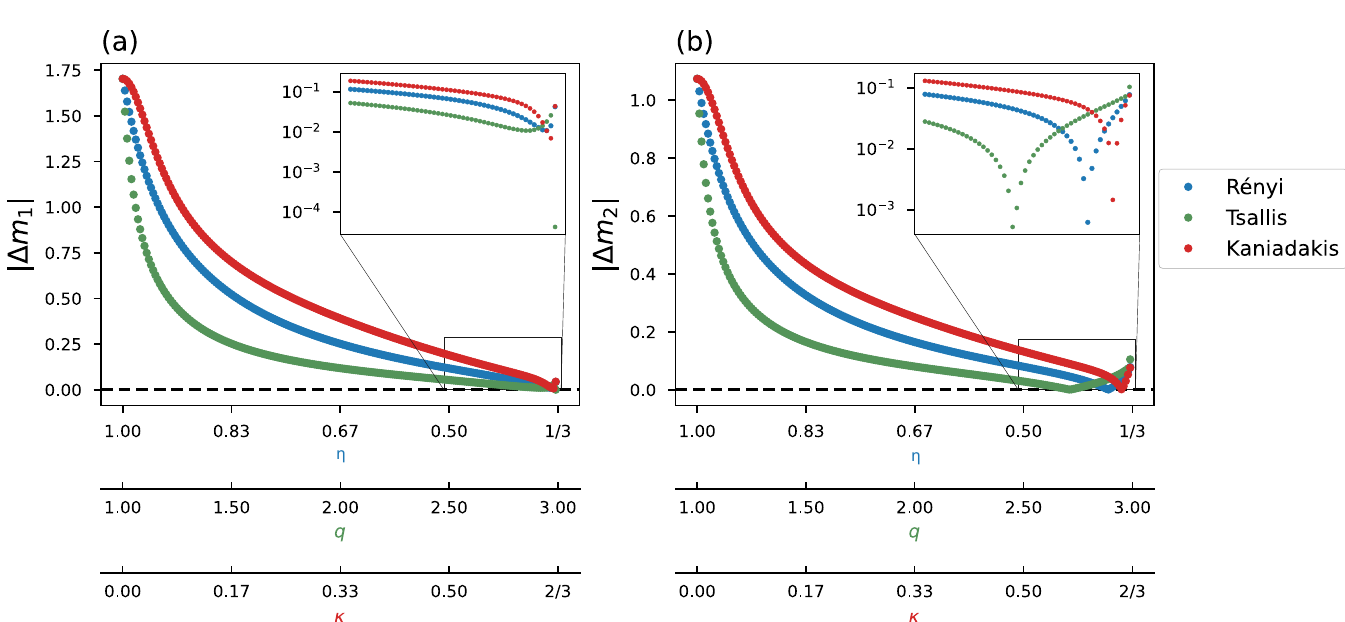
Fig 9. Relation between estimated parameters and entropic indexes. The zoom in window in (a) and (b) emphasizes the regions 0.5 � η < 1/3, 2.5 � q < 3 and 0.5 � κ < 2/3.